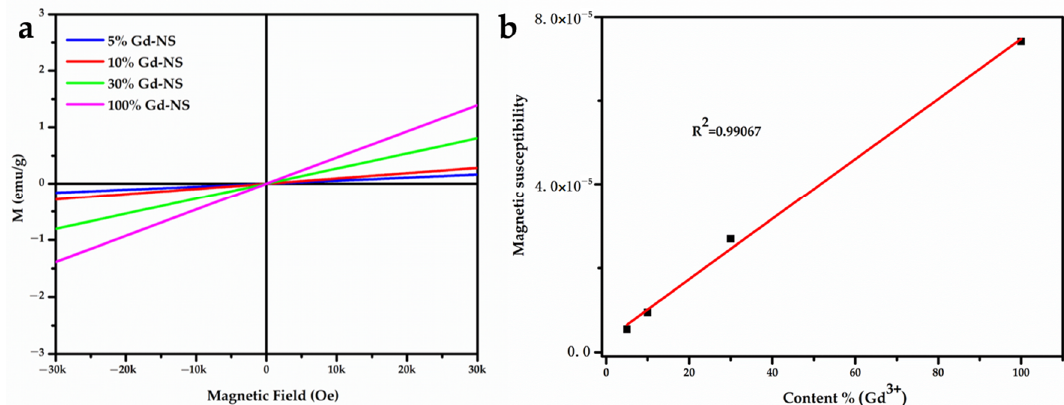
Figure 2. Magnetic hysteresis (M–H) loops of Gd/Y nanosheets at 300 K ( a ). The linear relationship between magnetic susceptibility and gadolinium content ( b